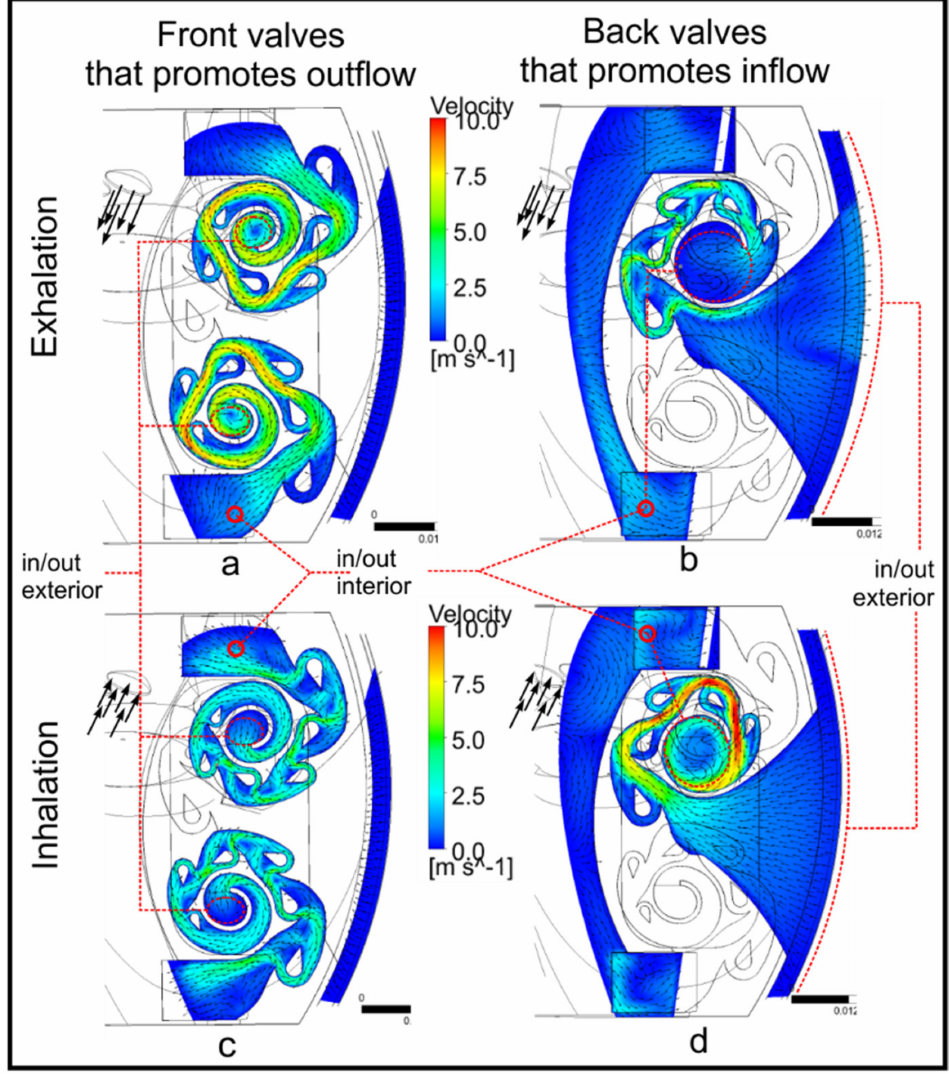
Figure 8. Contours of velocity flow into the mask. ( a ) Exhalation through valves that promote outflow; ( b ) exhalation through valves that promote inflow; ( c ) inhalation through valves that promote outflow; and ( d ) inhalation through valves that promote